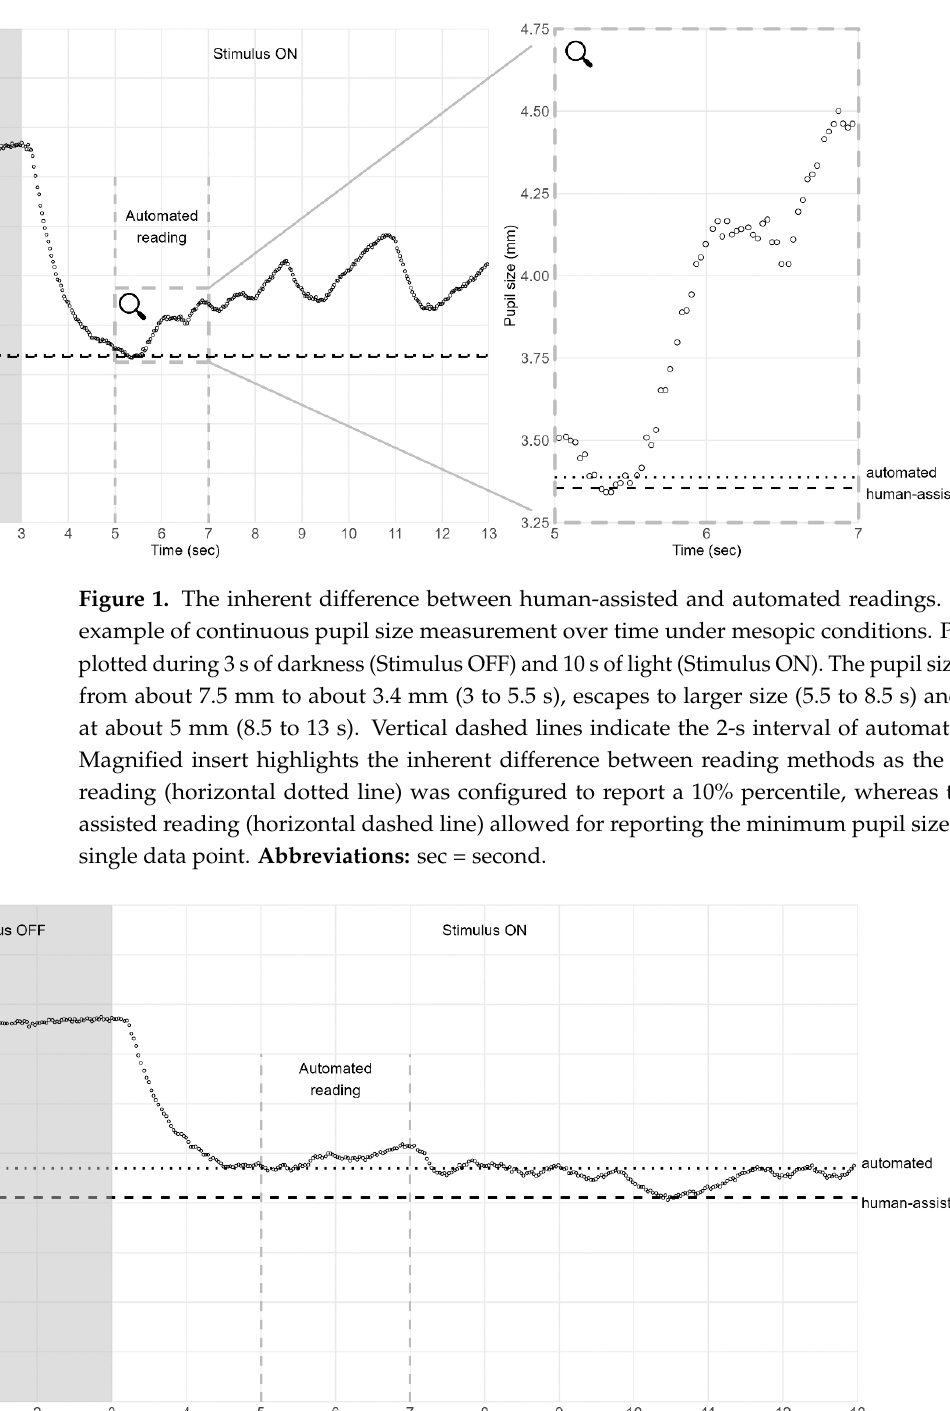
as w = q × e − 2 × d , where d was the absolute difference between the median and the 10% percentile.